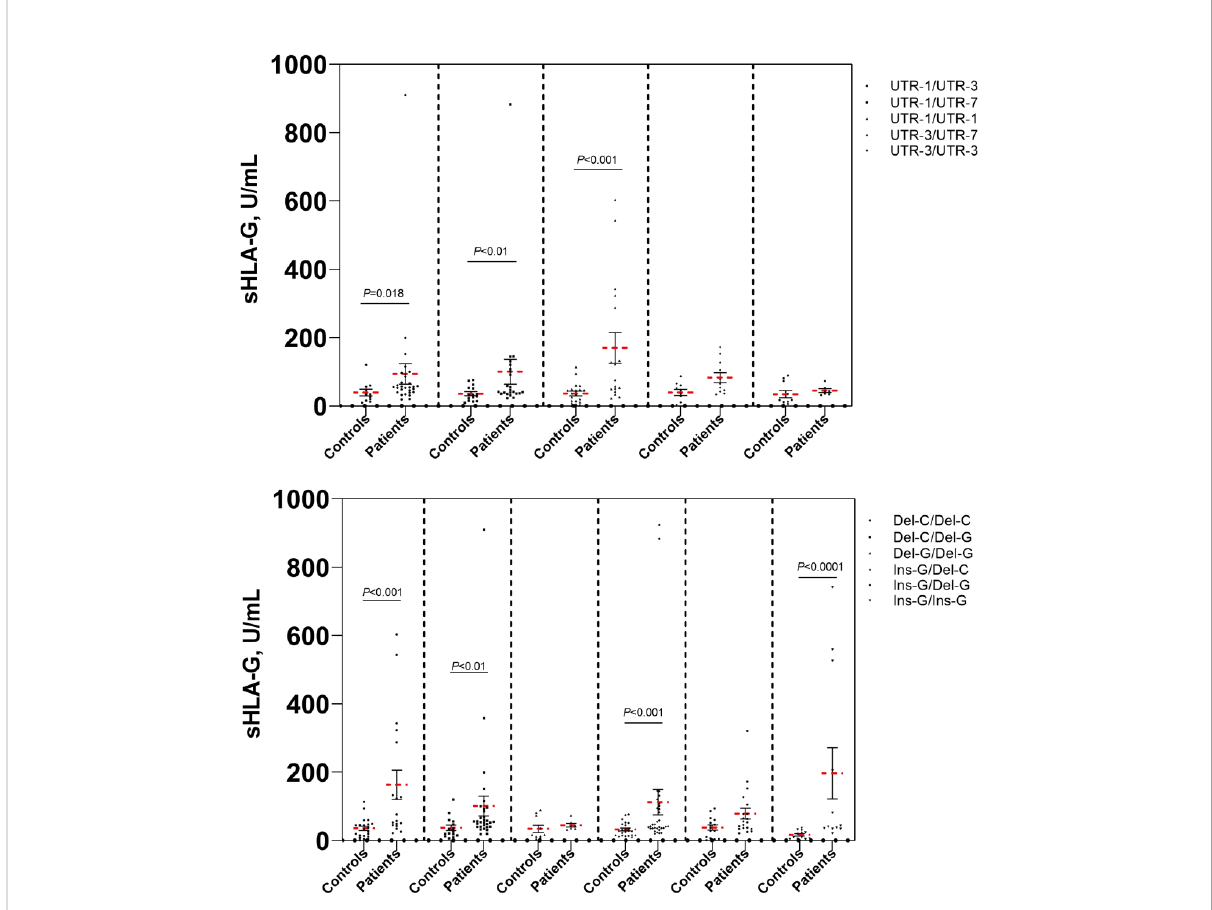
FIGURE 4 Comparison of sHLA-G levels of cervical cancer patients and healthy controls. Bars indicate mean ±